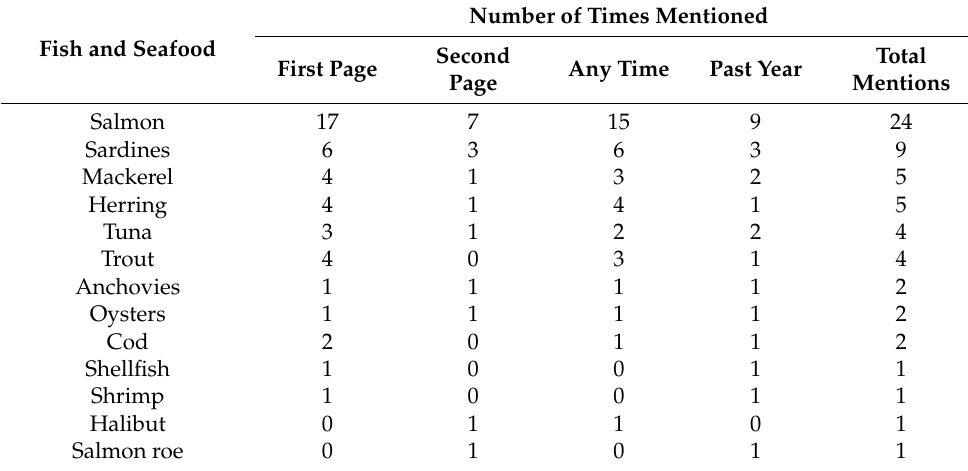
Table 3. Classification of fish and seafood by the number of times that were mentioned on selected web